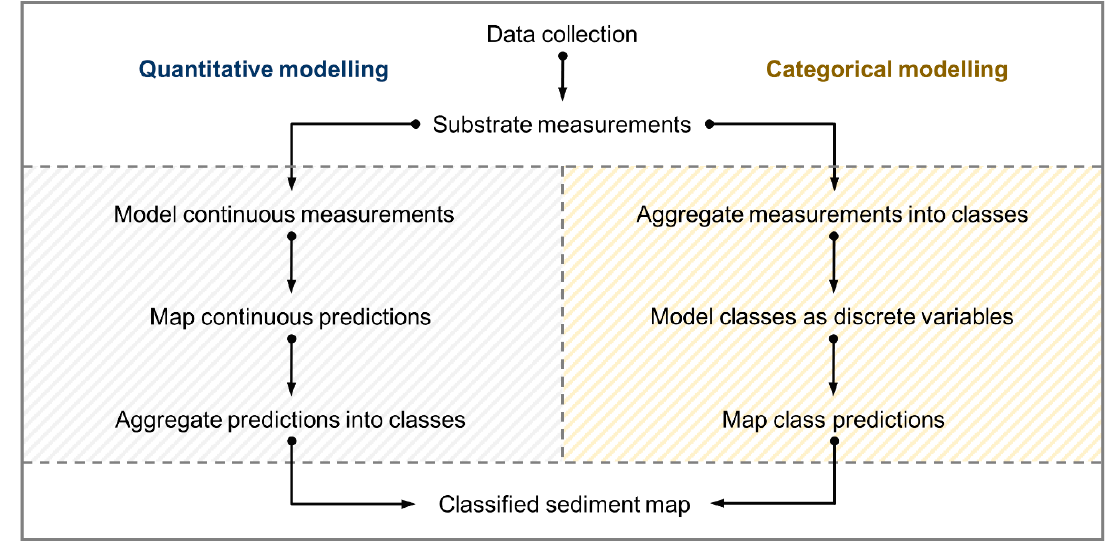
Figure 2. Two common supervised workflows for producing objective classified seabed sediment maps.